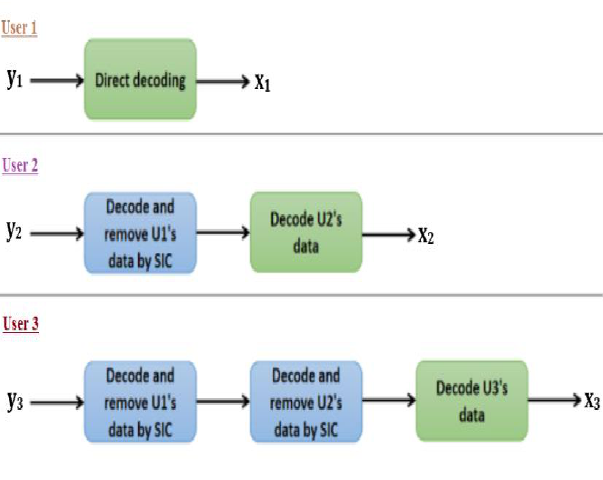
Figure 3. The working method of (SIC)